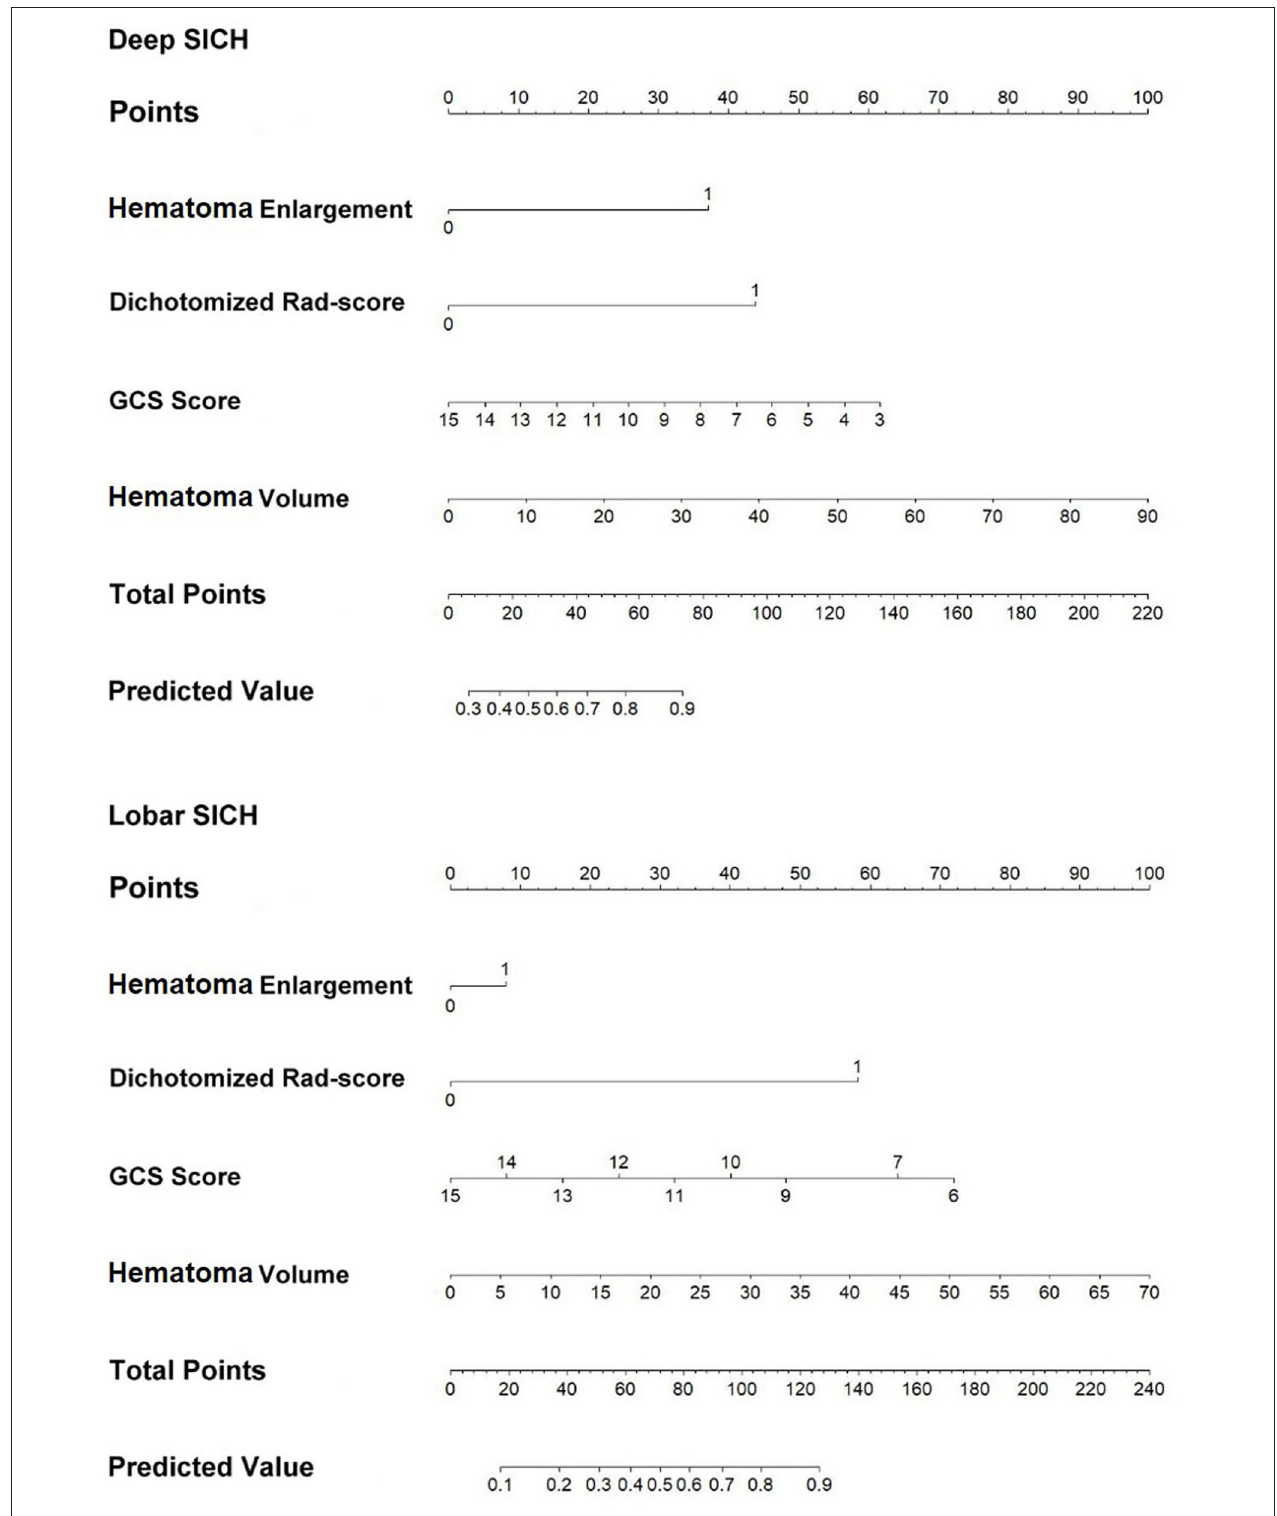
FIGURE 6 | Nomograms of the location-specific combined models for predicting 6-month poor outcome of deep and lobar SICH.